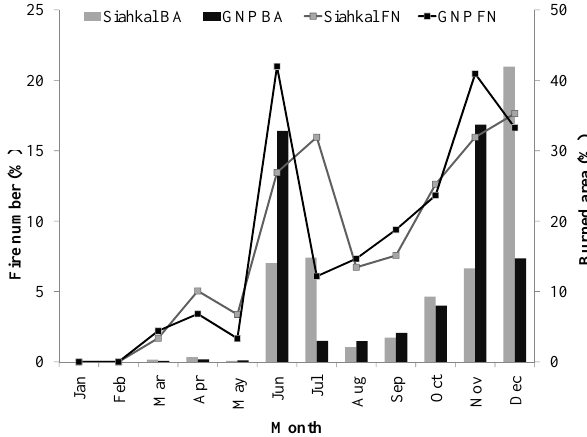
Figure 2. Monthly mean fire number (FN) and burned area (BA) in Siahkal forest area and GNP (2000–2011; data from Department of Forestry, Natural Resources Office, Guilan, and Department of En- vironment, Golestan, Iran, personal communication, 2011,